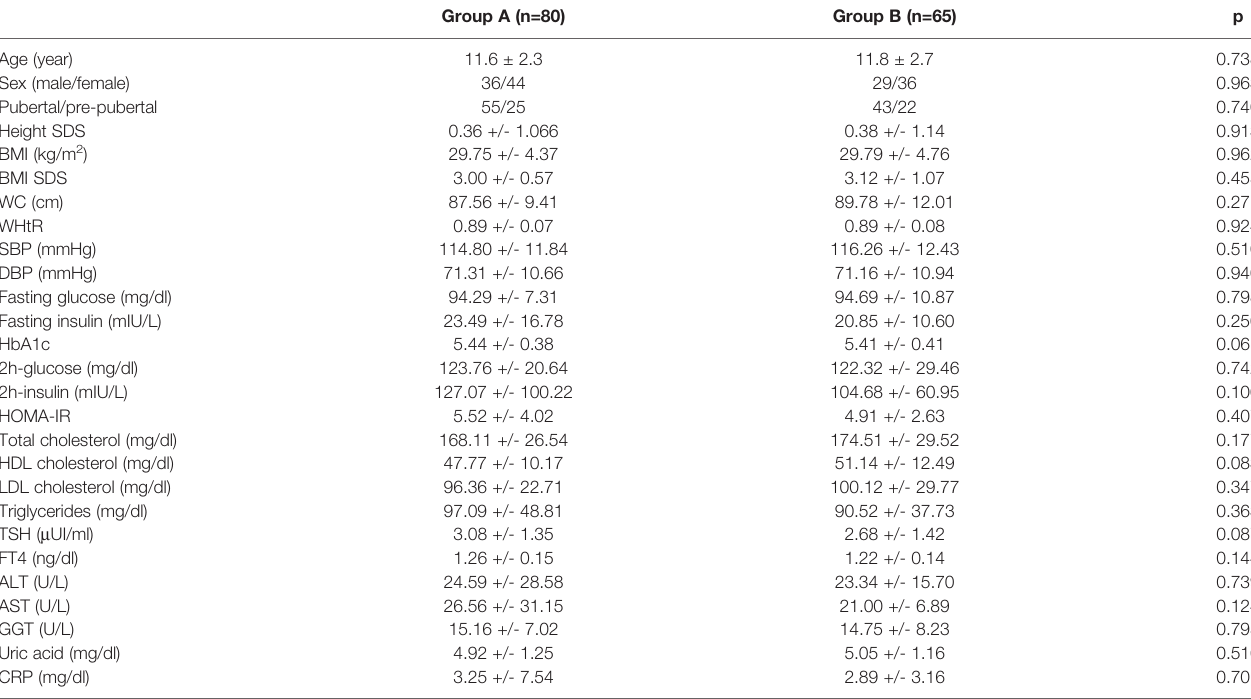
TABLE 1 | Comparison analysis between group A and group B on baseline clinical and biochemical